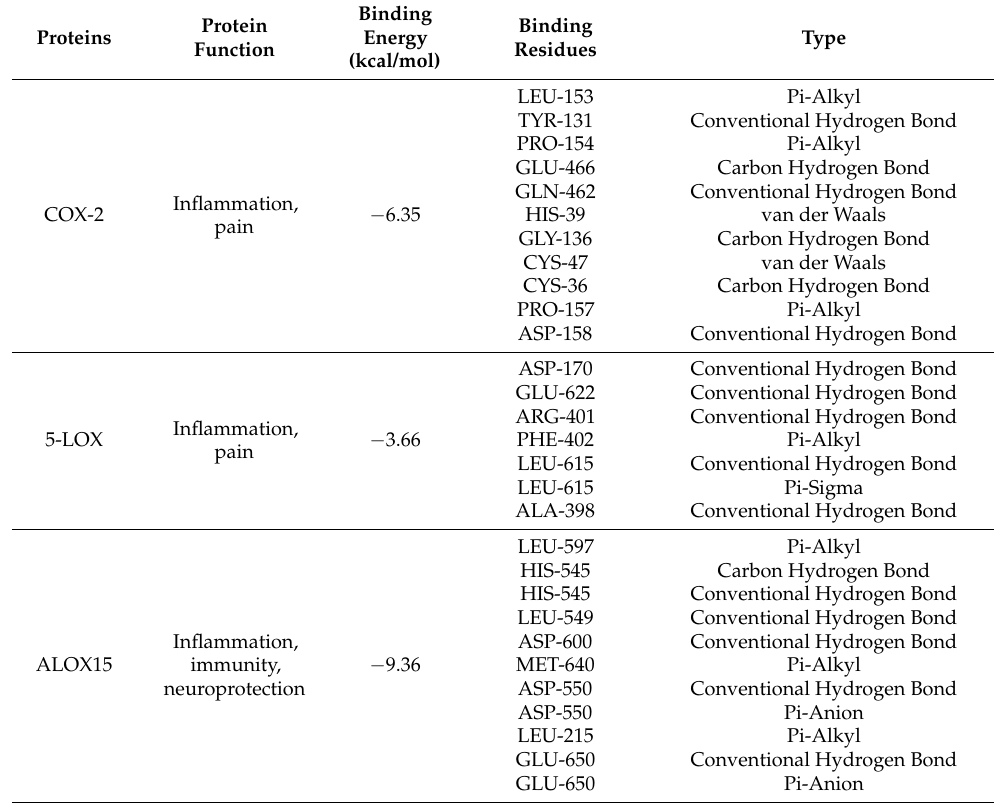
Table 1. Intermolecular interactions between Fr11 and COX-2, 5-LOX, and ALOX15. Binding Protein Proteins Function